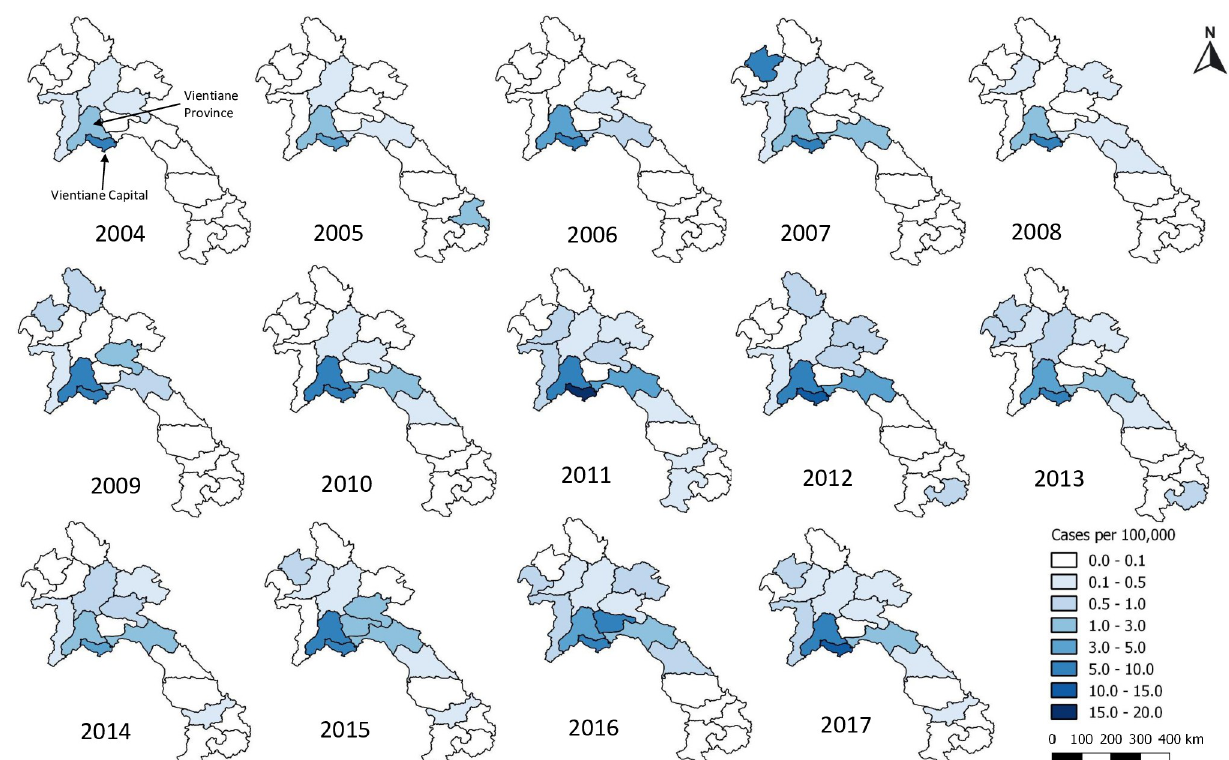
Fig 1. Patients with scrub typhus per 100,000 people per province in Laos from 2004–2017. Maps were created using QGIS version 3.4.9. All layers were created by the authors of this manuscript.